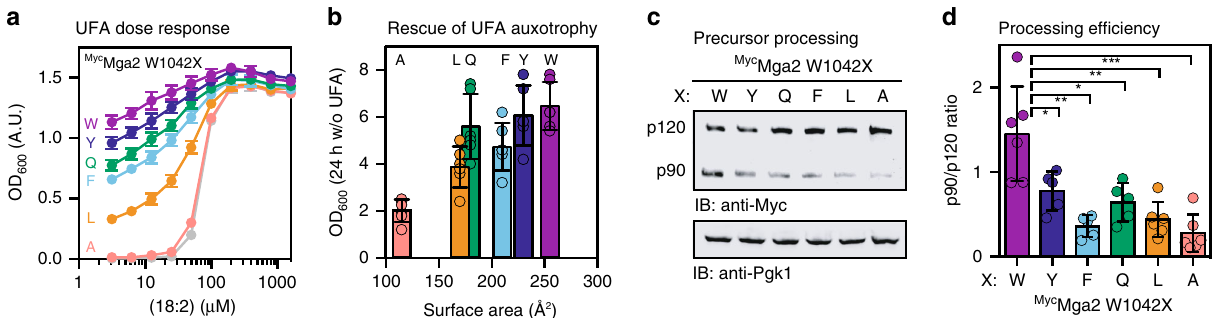
Fig. 6 The activity of Mga2 is tuned by mutations in the sensory TMH. a Dose-dependent rescue of UFA auxotrophy by linoleic acid (18:2). Δ SPT23 Δ MGA2 strains carrying CEN -based plasmids to produce Myc Mga2 variants with the indicated residues at position 1042 were cultivated for 16 h at 30 °C in SCD-Ura medium supplemented with indicated concentrations of linoleic acid in 0.8% tergitol. The density of the culture was determined at 600 nm (OD 600 ) and plotted against the concentration of linoleic acid. Cells carrying an empty vector served as control (gray). Plotted is the mean ± SEM ( n = 8). b Rescue of UFA auxotrophy of Δ SPT23 Δ MGA2 by Mga2 variants. Cells producing mutant Mga2 as in a were cultivated for 24 h in the absence of supplemented UFAs in SCD-Ura medium. Cell density was determined as in a and was plotted against residue surface area of residues installed at position 1042 66 . Plotted is the mean ± SEM of fi ve independent experiments. The dotted line indicates the OD measured for an empty vector control. c Immunoblot analysis of the Mga2 processing ef fi ciency. Wild-type cells (BY4741) producing the indicated Myc Mga2 variants at position 1042 were cultivated in full medium (yeast extract – peptone – dextrose; YPD) to the mid-exponential phase. Cell lysates were subjected to SDS-PAGE and analyzed via immunoblotting using anti-Myc antibodies to detect the unprocessed (p120) and the processed, active form (p90) of Mga2. An immunoblot using anti-Pgk1 antibodies served as loading control. d Densiometric quanti fi cation of the ratio of p90:p120 in immunoblots as in c . Signal intensites were quanti fi ed using Fiji and plotted as mean ± SD ( n W = 6, n Y = 5, n F = 5, n Q = 5, n L = 6, n A = 6) 67 . A two-tailed, unpaired t -test was performed to test for statistical signi fi cance (* p < 0.05, ** p < 0.01, *** p < 0.001). Source data are provided as a Source Data fi